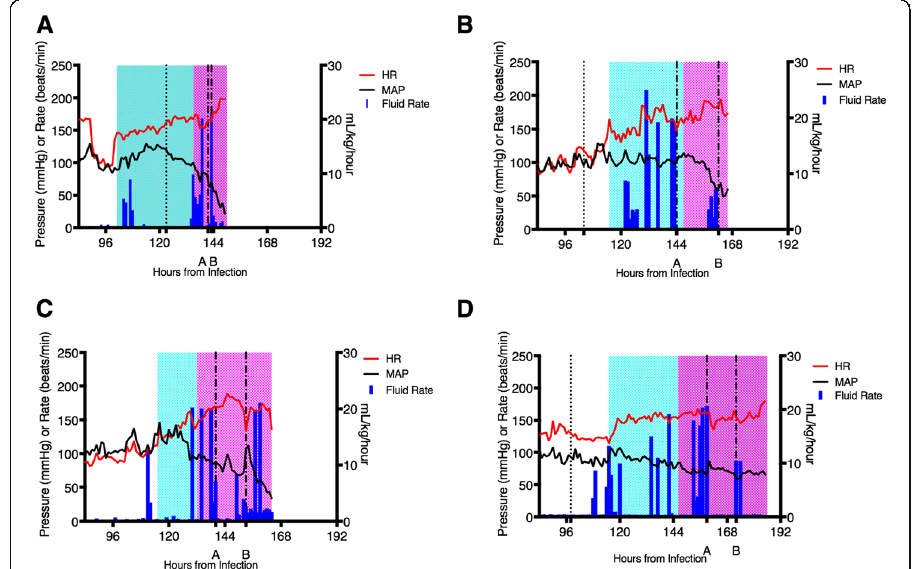
Fig. 1 Cardiovascular vital sign trends and fluid Resuscitation. Trends in cardiovascular vital signs in relation to interventions. a – d NHP1 – 4, respectively. HR (measured in beats per minute) and MAP (measured in mmHg) are plotted on the left Y -axis. The vertical dashed line in a , b , and d represents the first detection of viremia (for NHP3 ( c ), first detection occurred earlier than this time scale). The vertical lines labeled “ A ” and “ B ” in those same panels represent the start of the first and second vasoactive medications, respectively. Cyan-shaded areas represent compensated shock while magenta-shaded areas represent decompensating shock. The vertical blue bars denote fluid rate in mL/kg/hour; bars significantly above the baseline represent fluid boluses. The initial high heart rate for NHP1 ( a ) is secondary to acidosis. Once the acidosis began to resolve, the heart rate stabilized until the onset of EVD-related